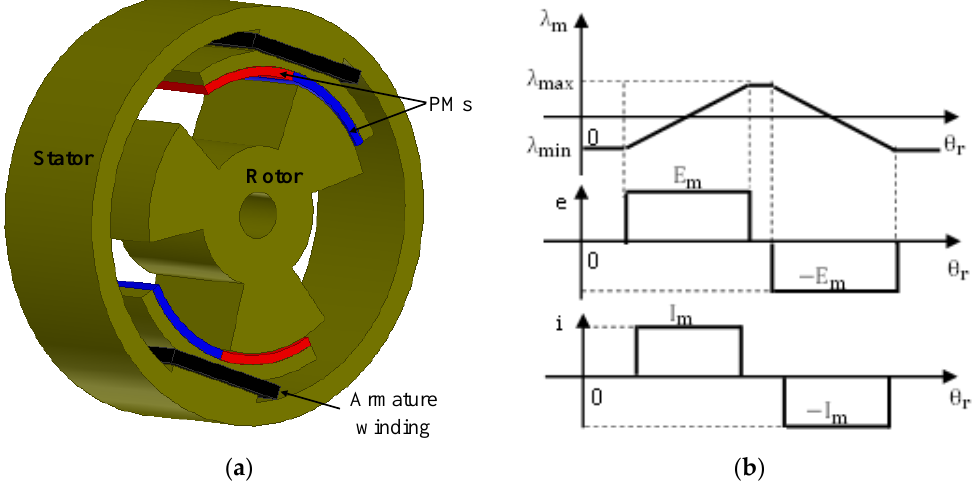
Figure 6. 2/3-pole single-phase FRPMM: ( a ) basic topology; ( b ) flux linkage, back-emf, phase current waveforms.